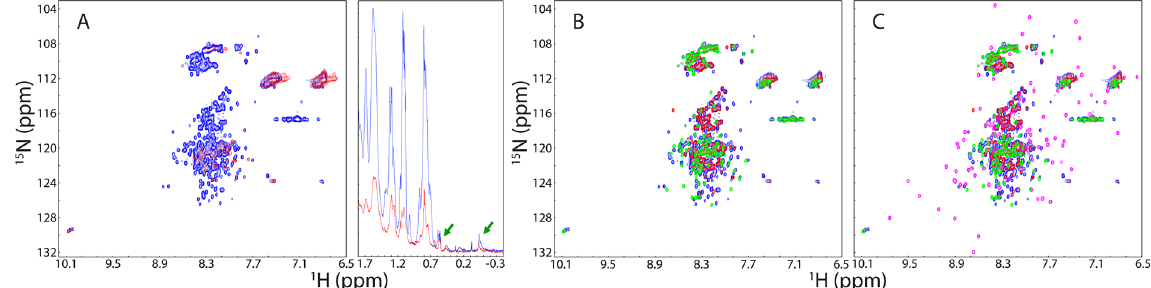
Figure 3. NMR characterization of the full-length FUS. ( A ) Superimposition of 2D NMR HSQC and 1D 1 H spectra of the full-length FUS protein at a protein concentration of 40 µ M in 1 mM phosphate buffer at pH 5.0 (blue) and pH 6.8 (red). The green arrows are used to indicate up-field peaks manifested in 1D spectra characteristic of a well-folded protein. ( B ) Superimposition of 2D NMR HSQC spectra of the full-length FUS protein (blue), N-terminal LC domain (red) and C-terminal LC domain (green) in 1 mM phosphate buffer at pH 5.0. ( C ) Superimposition of 2D NMR HSQC spectra of the full-length FUS protein (blue), N-terminal LC domain (red); RRM (pink); and C-terminal LC domain (green) in 1 mM phosphate buffer at pH